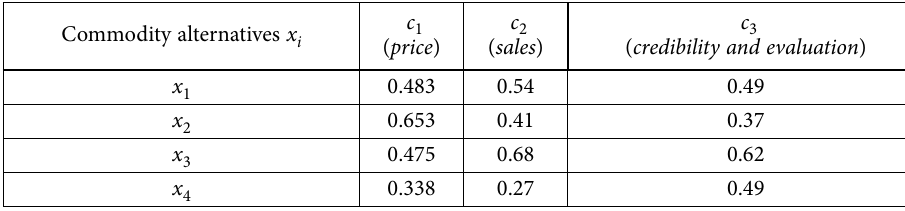
Table 3. Normalized decision matrix Commodity alternatives x